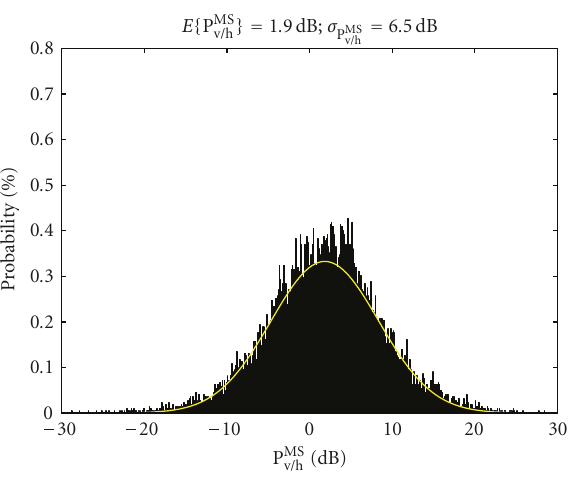
Figure 15: PDF of the XPR MS Rx27.